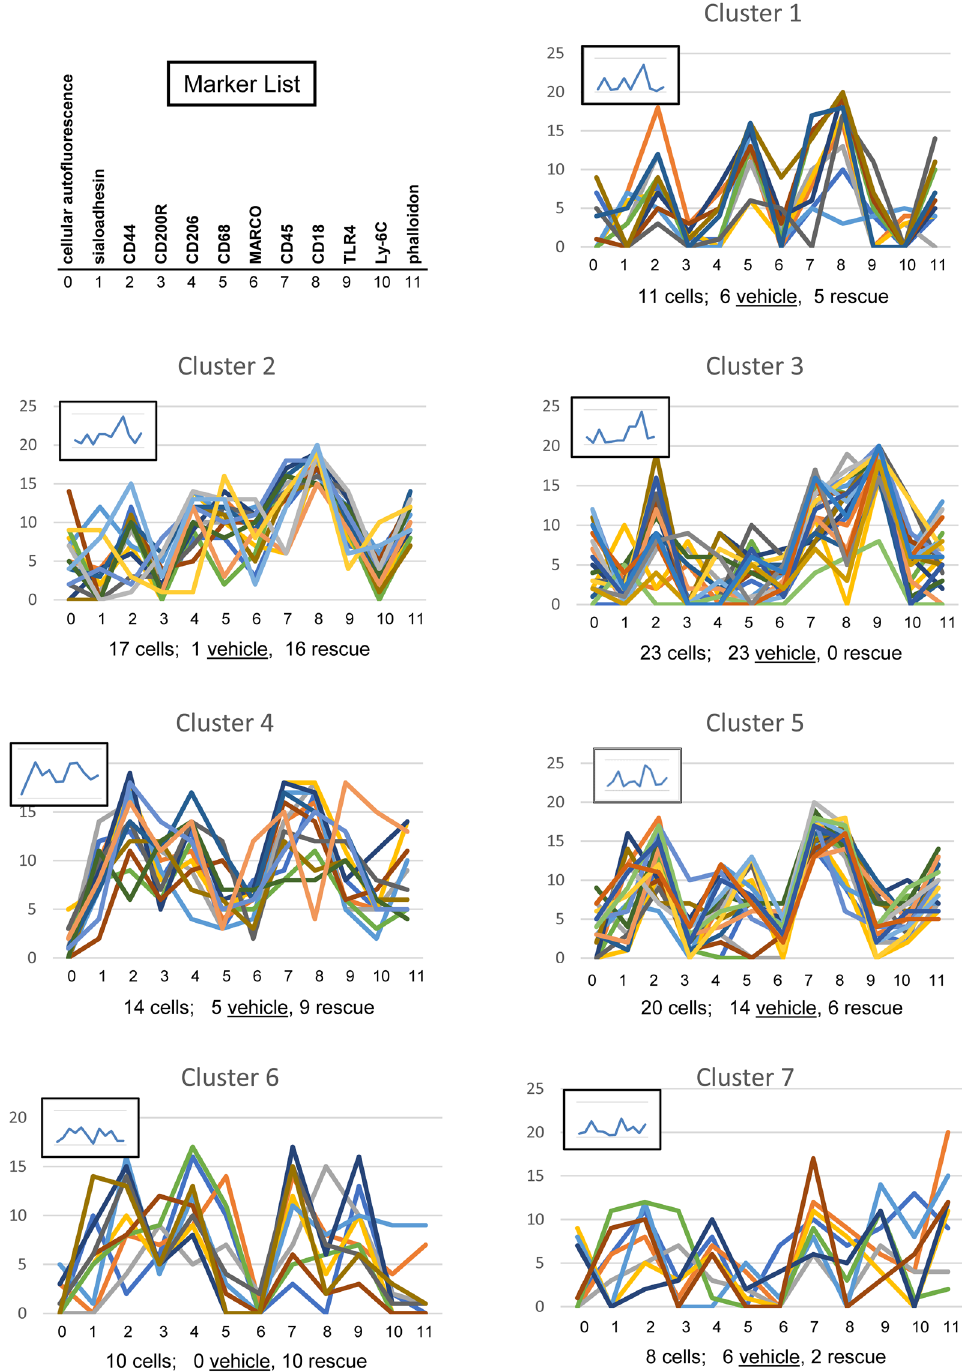
Figure 5. Graphs of cells in each female cluster. The CMP summary of all cells in a given cluster (from Fig. 4) is shown from the 103 AM from female mice. The first panel shows a marker list equating each marker number with a specific protein. Each line represents a single cell and the summary statistics indicating total cell numbers and number of vehicle- and SP-A-treated cells in each cluster are given below each graph. The inset shows a graph summarizing all cells in the cluster based on the mean values of all markers in all